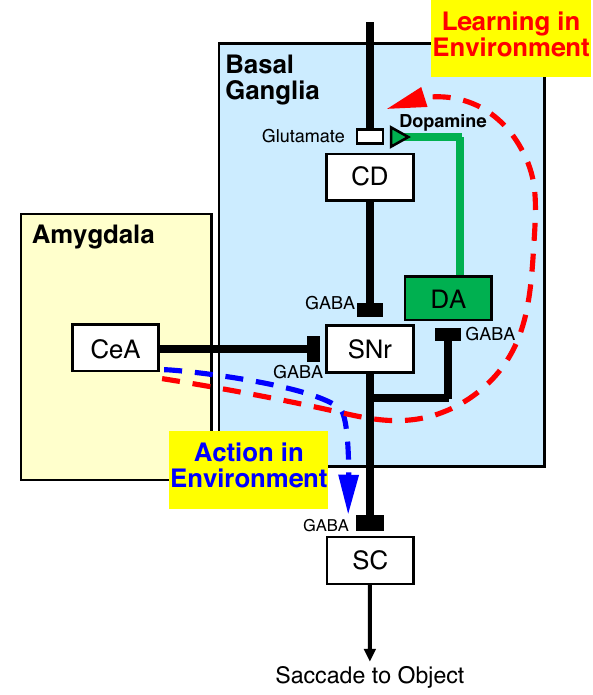
Fig. 6 | Two pathways arising from amygdala for controlling BG circuit. The solid lines indicate the anatomical pathways of GABAergic or Dopaminergic terminals. The dotted lines show hypothetical information fl ow through the amygdala-BG circuits for learning and action in environmental